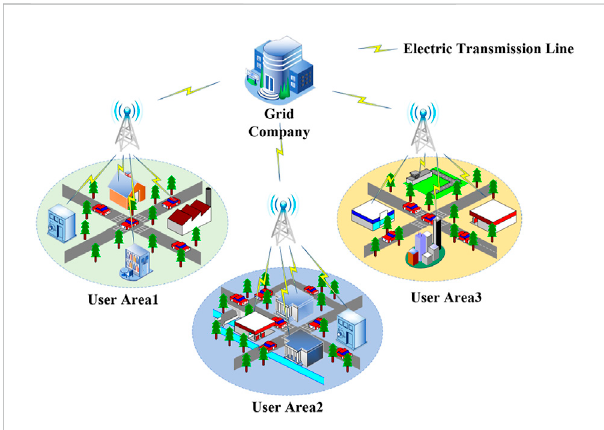
FIGURE 1 Electricity consumption framework of power grid